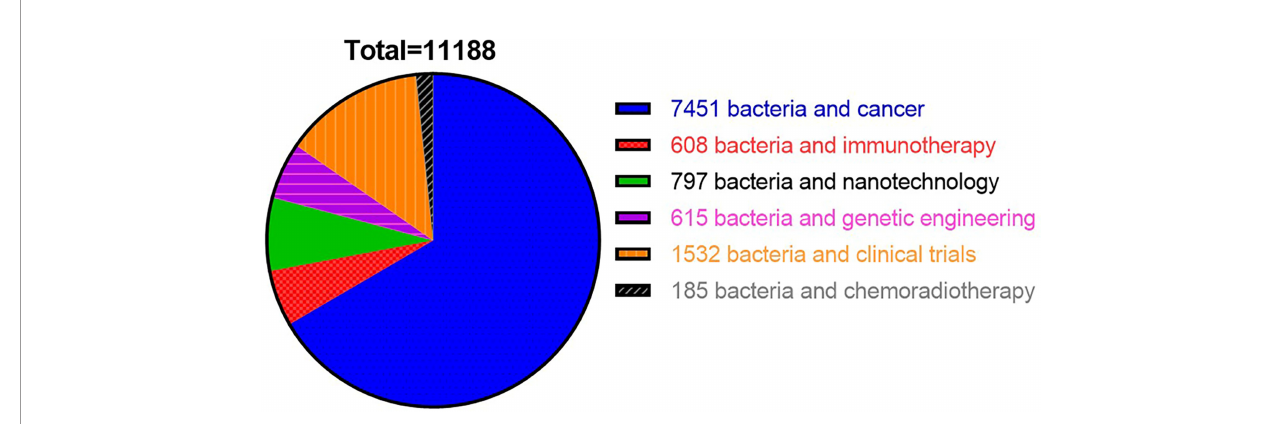
FIGURE 1 | Statistical chart showed overall number of studies published in PubMed from 2012 to 2022 using different